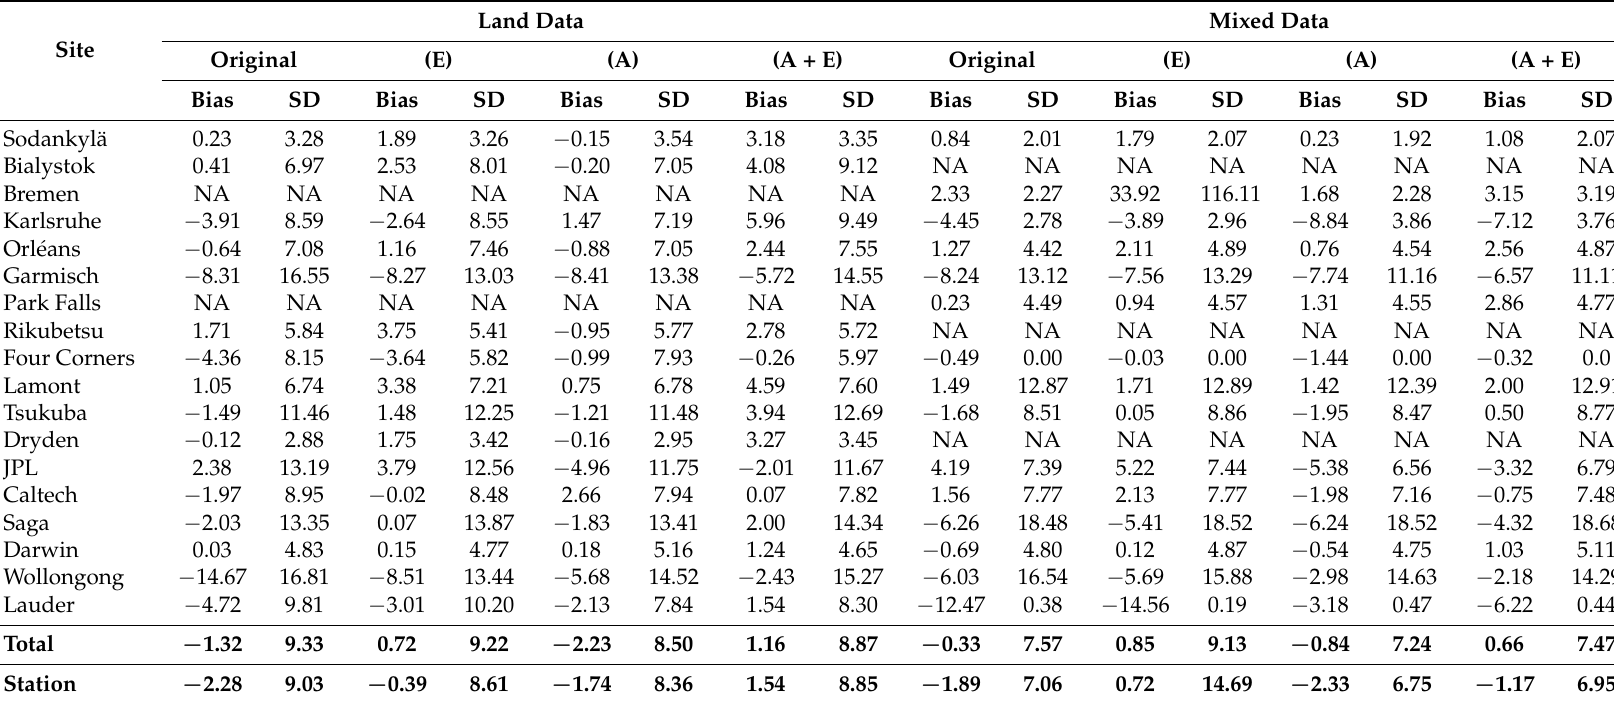
Table 5. Comparison of biases and standard deviations (SD) among the three bias correction methods at the 18 TCCON sites for case 0. (E) Empirically derived bias correction, (A) altitude bias correction, and (A + E) altitude bias correction followed by empirically derived bias correction. NA, not